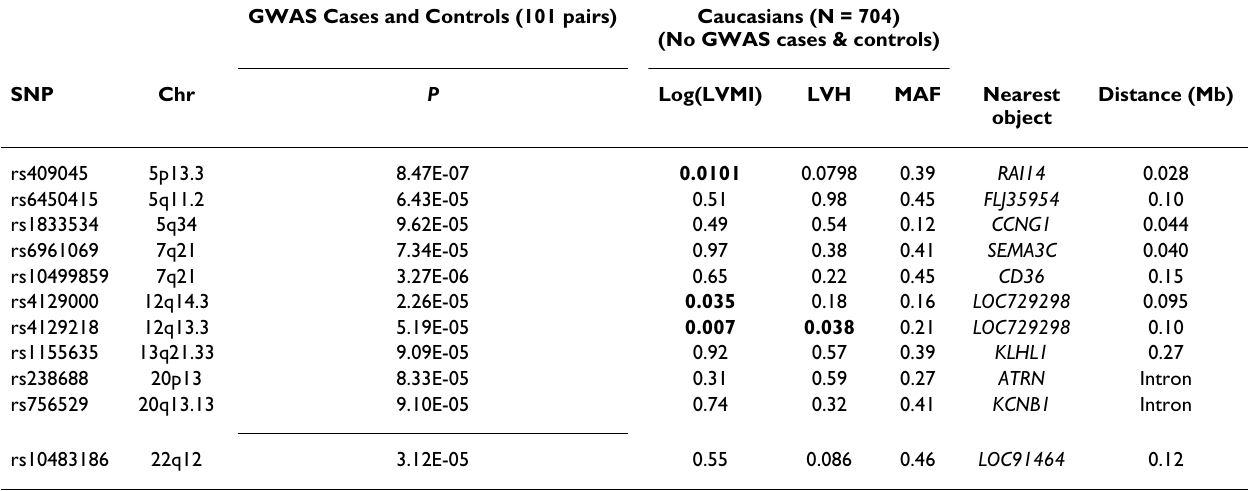
Table 3: Results (as P values) from the validation study genotyping and association analyses for the Caucasian sample, not including GWAS cases and controls.* GWAS Cases and Controls (101 pairs)